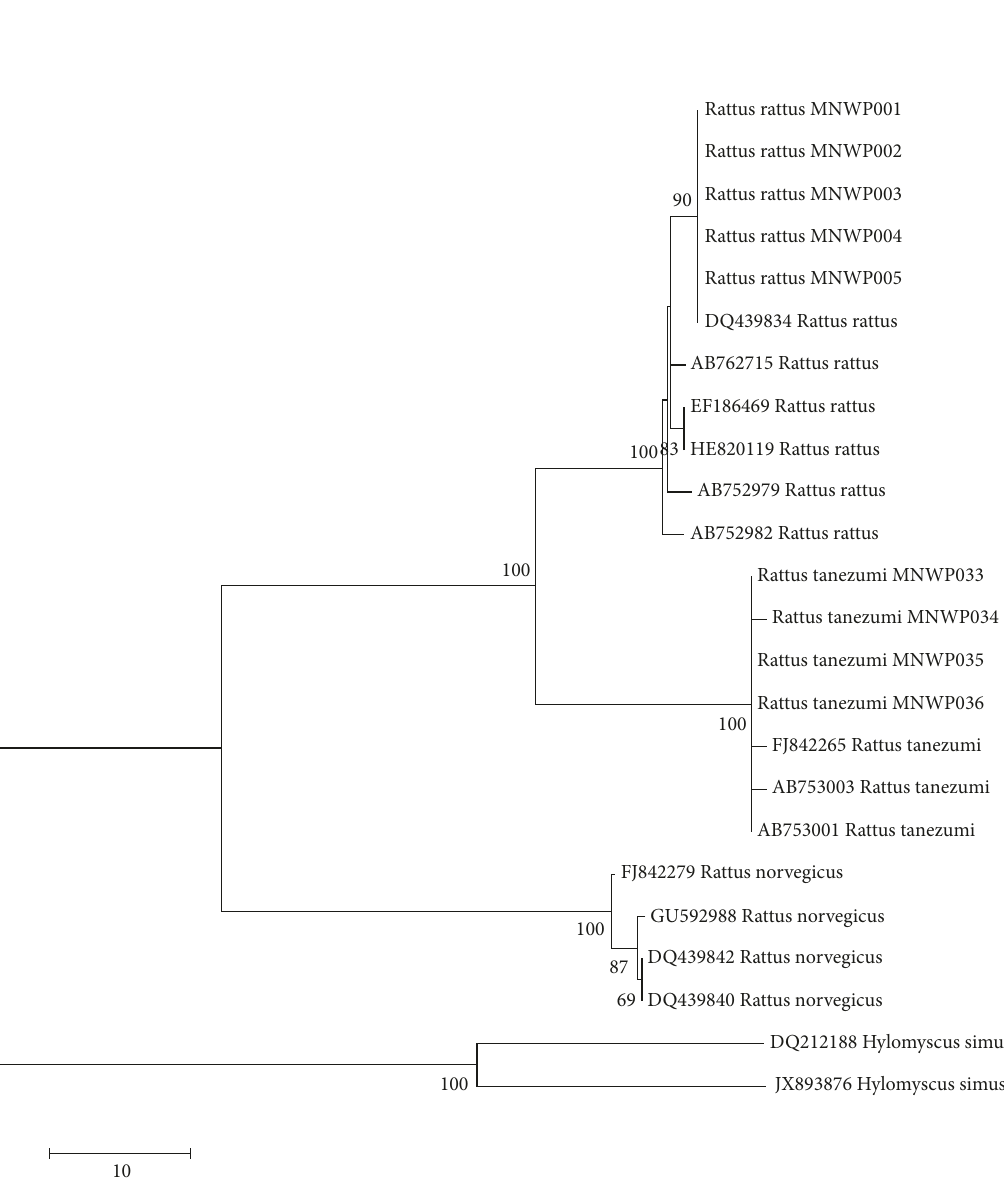
Figure 4: Neighbour-joining tree from the Cyt-b gene. The analysis involved 24 nucleotide sequences whereby 9 sequences were derived from this study and the remaining from the NCBI database with 1000 replicates. All positions containing gaps and missing data were eliminated. There were a total of 608 positions in the final